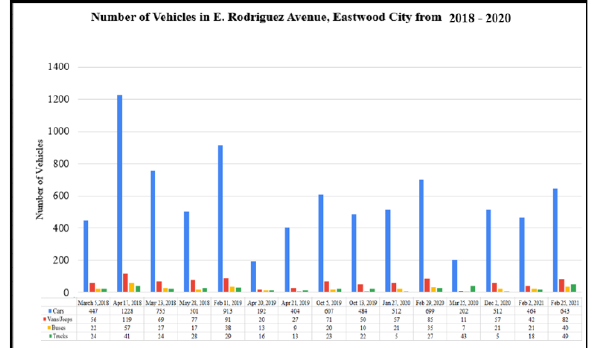
Figure 9. Number of Vehicles per Classification in E.